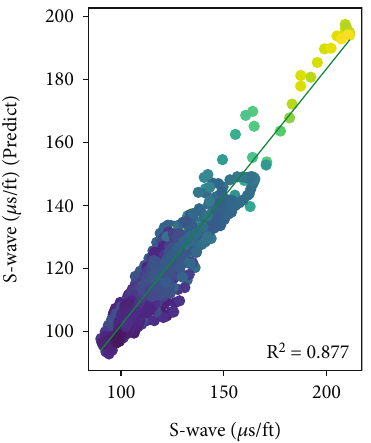
Figure 14: The correlation between shear wave velocity and